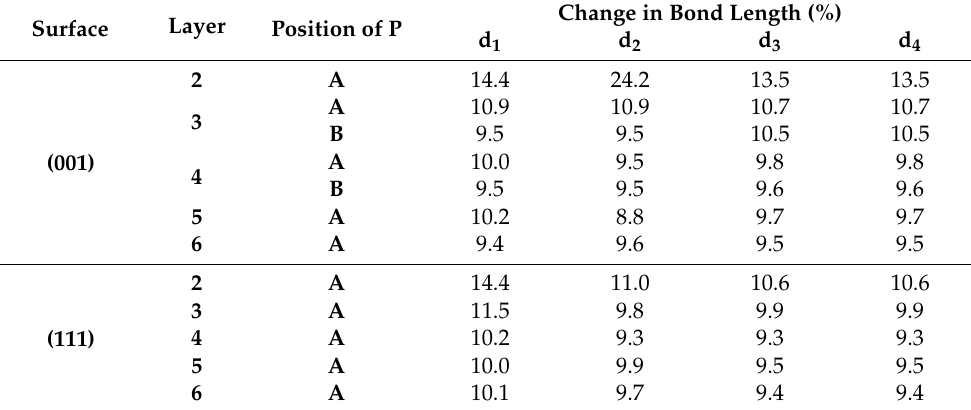
Table 2. Change of typical bond lengths of a single P atom with its surrounding C atoms. The result of changing in bond length comes from: (length after doping − length before doping)/ length before